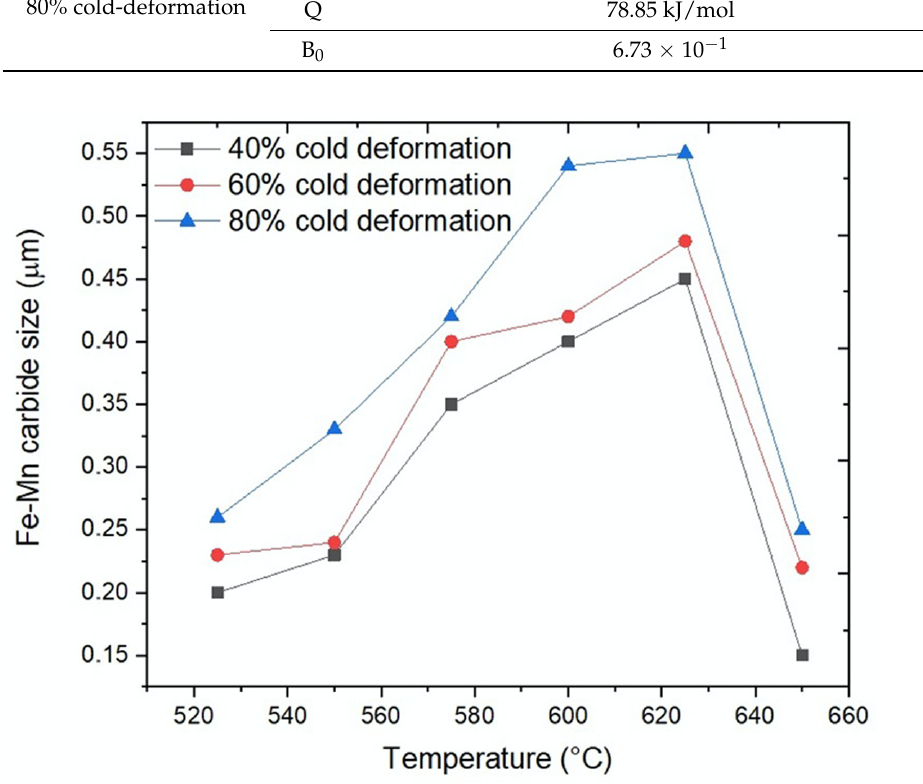
Figure 10 . Temperature vs. time to 0.1 vol% (Fe,Mn) 3 C precipitation. Fe-Mn-carbide precipitate size was correlated with cold-deformation and tempera- ture for 24-h annealing, as shown in Figure 11. The average precipitate size after 24-h an- nealing at different temperatures was determined with Image-Pro-Plus-6 software [25].